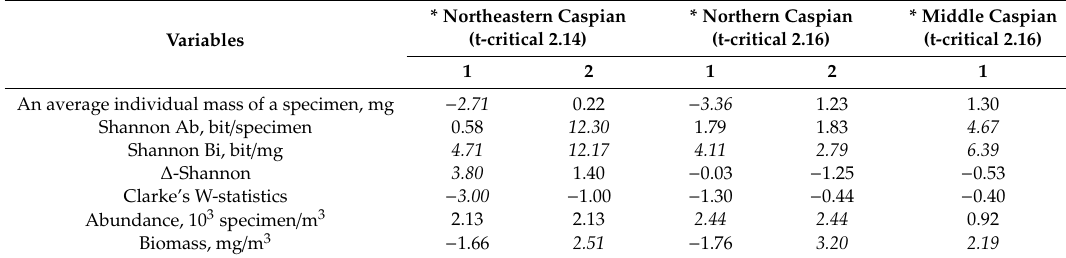
Table 7. Evaluation of seasonal changes in the structure of zooplankton communities in the surveyed areas of the Caspian Sea according to Student’s t -test, p < 0.05. * Northeastern Caspian * Northern Caspian * Middle Caspian (t-critical 2.14) (t-critical 2.16) (t-critical 2.16) Variables 1 2 1 2 1